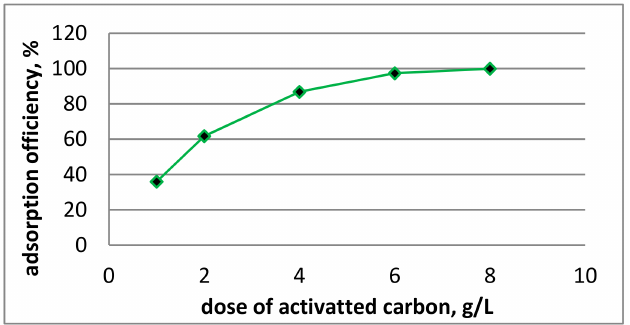
Figure 4. E ff ect of the doses of activated carbon WG-12 on the e ffi ciency of chloramphenicol adsorption.